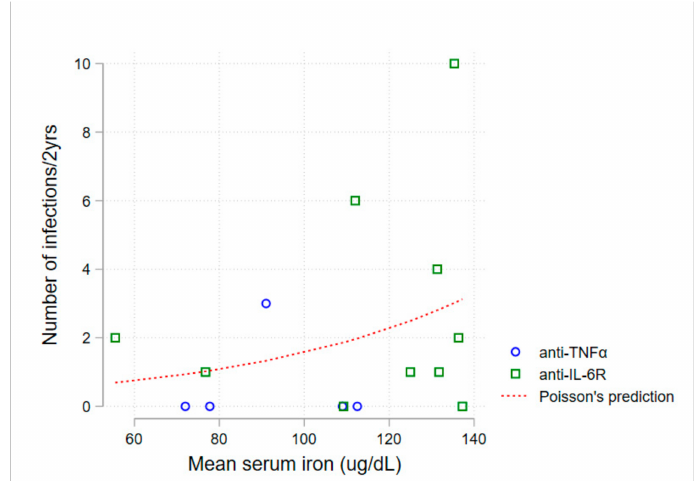
Figure 2. Relationship between mean serum iron level and number of infections during follow-up of patients both on anti-IL-6R (green squares) and anti-TNF α (blue circles) subgroups. The Poisson regression curve is depicted (dashed red), p = 0.030. Anti-IL-6R—anti-interleukin-6 receptor; anti-TNF α —antitumor necrosis factor α .